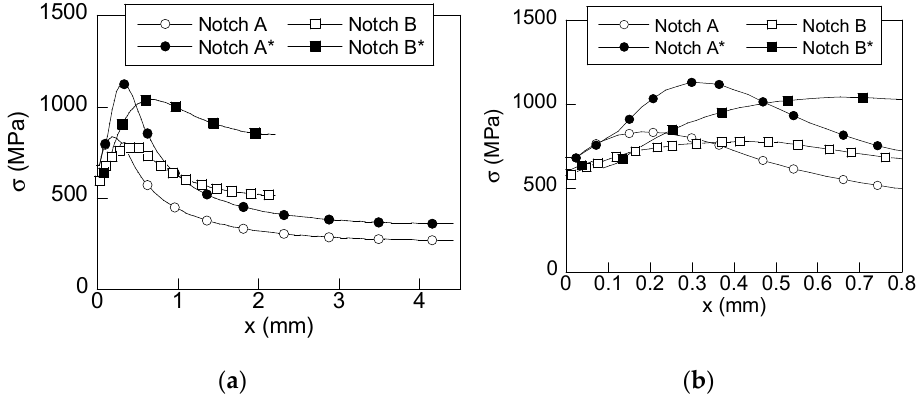
Figure 4. Radial distributions of hydrostatic stress generated in preloaded (filled) and un-preloaded (blank) specimens at an instant corresponding to the in-service loading (70% P R ): ( a ) general distribution and ( b ) detailed view of the near-to-surface zone.